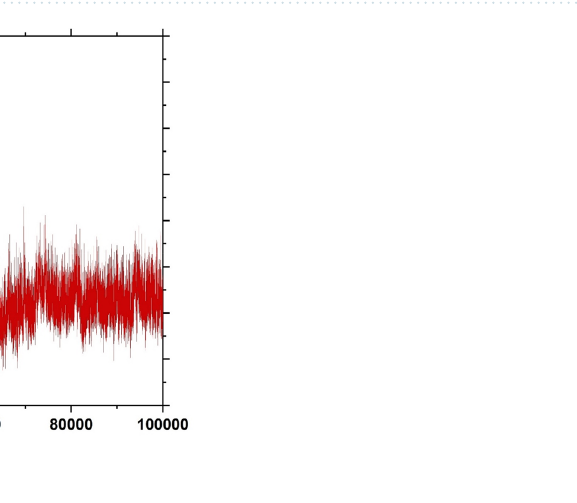
Figure 3. The interaction energy between the drug molecules and the carriers as a function of